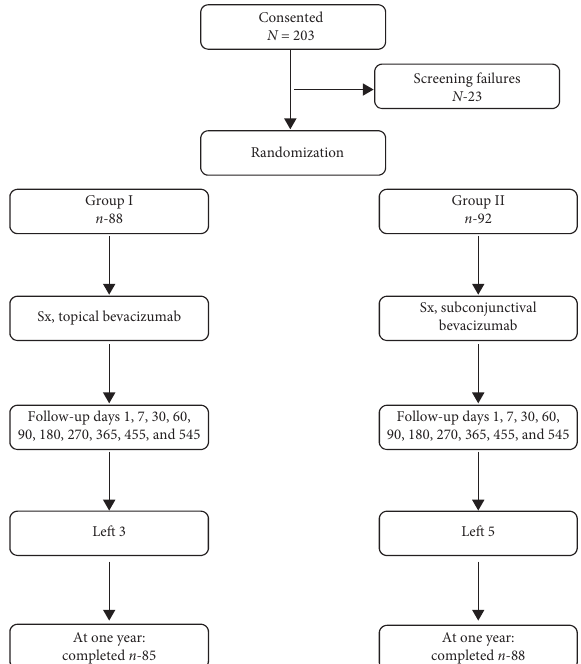
Figure 1: Flow chart for the